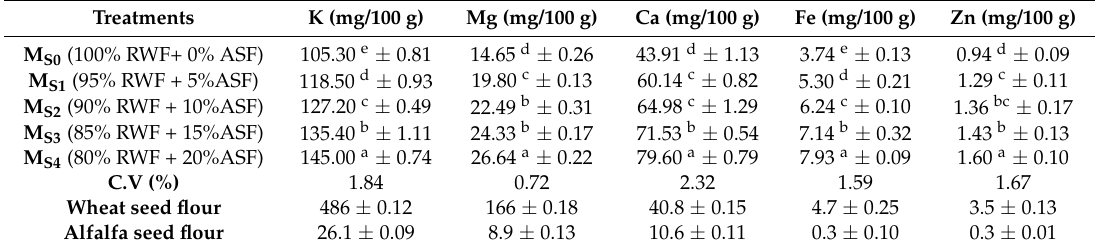
Table 5. Mineral contents of control and supplemented